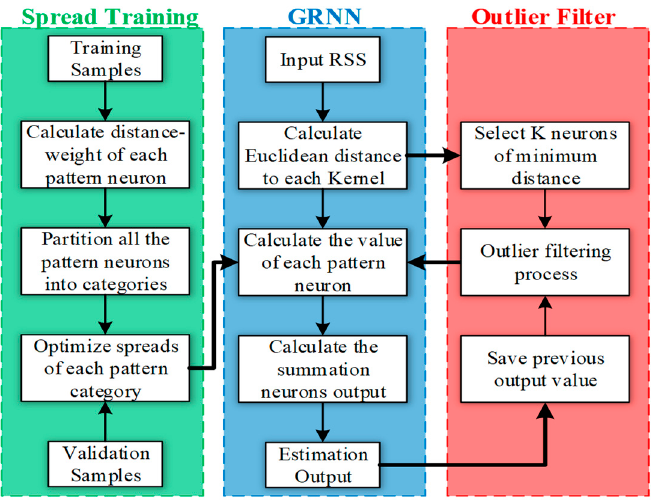
Figure 2. GROF method flow chart.